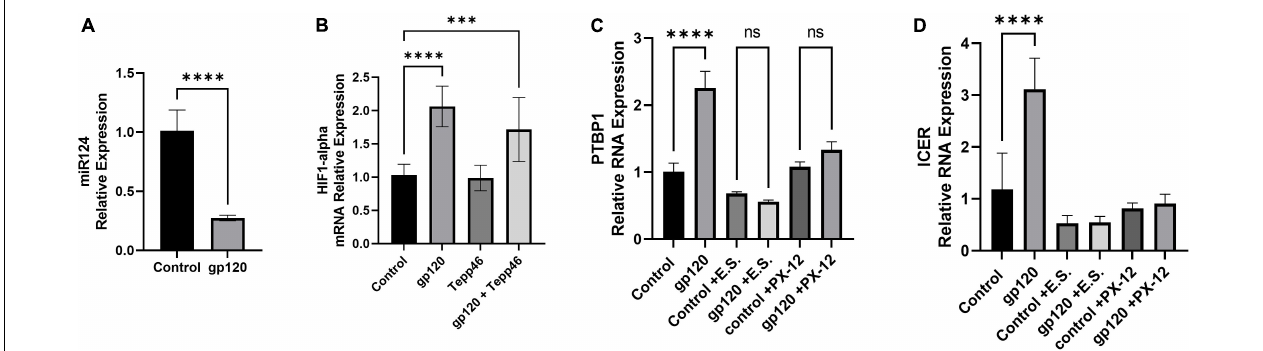
FIGURE 10 | Effects of gp120 on miR-124 and HIF-1 α and HIF-1 α inhibition on metabolic reprogramming. (A) Fold changes of miRNA-124 expression in gp120-treated LUHMES cells compared to control untreated cells obtained by qPCR. (B) Expression of HIF-1 α mRNA in gp120-treated LUHMES cells compared to control untreated cells obtained by qPCR. (C) Differentiated LUHMES cells untreated or treated with HIF-1 α inhibitors, E.S. or XP-12 as indicated. Expression of PTBP1 as obtained by qPCR. (D) Differentiated LUHMES cells untreated or treated with HIF-1 α inhibitors, E.S. or XP-12 as indicated. Expression of ICER mRNA as